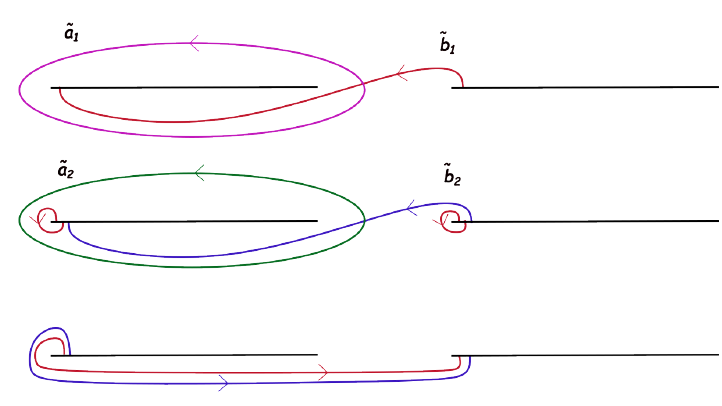
Figure 8 . Auxiliary homology basis for the Riemann surface Σ x for the case n = 3 . Horizontal black lines are branch cuts on the complex sheet. Left cut is ( x, 0) and the right cut is (1 , ∞ ) . We have depicted 3 complex sheets with each sheet represented by the horizontal couple of branch cut and coloured curves are the Auxiliary homology